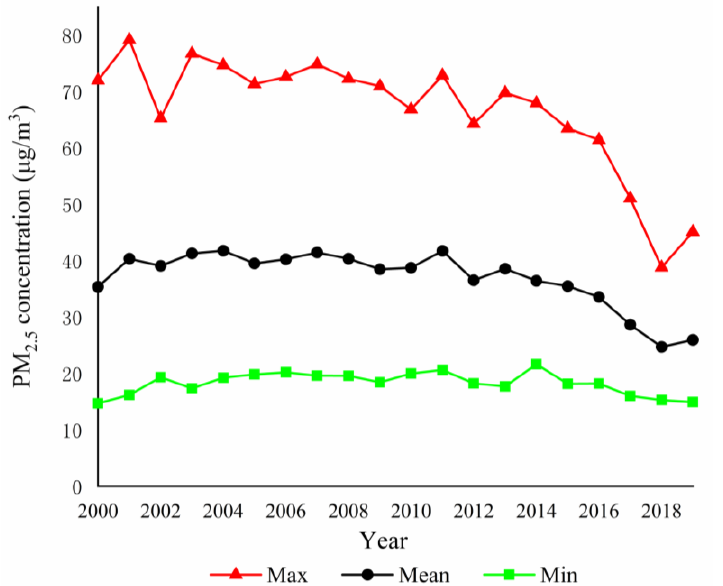
Figure 2. Maximum (red), mean (black), and minimum (green) values of annual mean of PM 2.5 concentrations in Zhejiang Province.